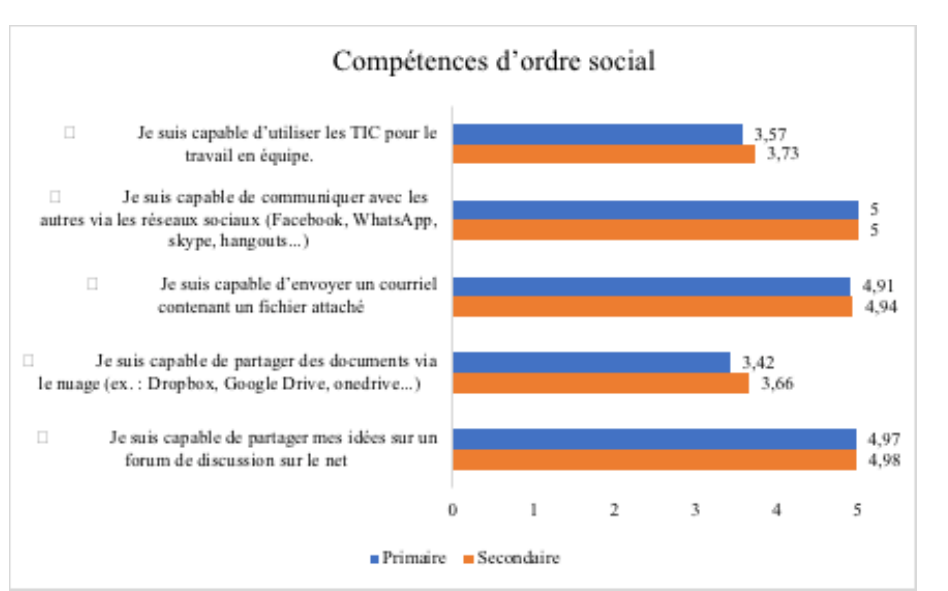
Fig.8. Les compétences d’ordre social déclarées maitrisées à l’issu de la formation au CRMEF.